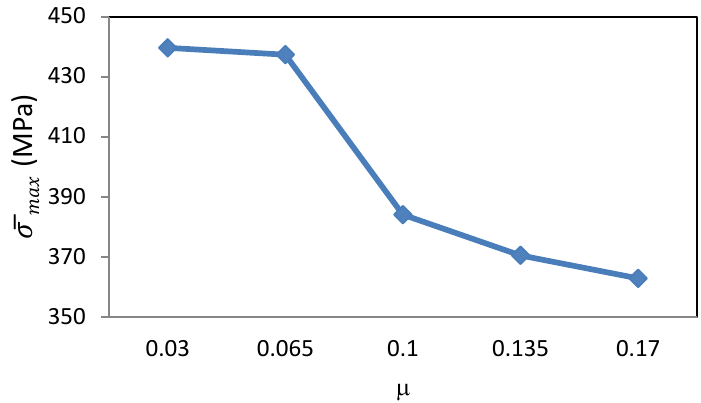
Figure 14. Influence of the friction on the cores maximum effective stress (T = 200 °C).